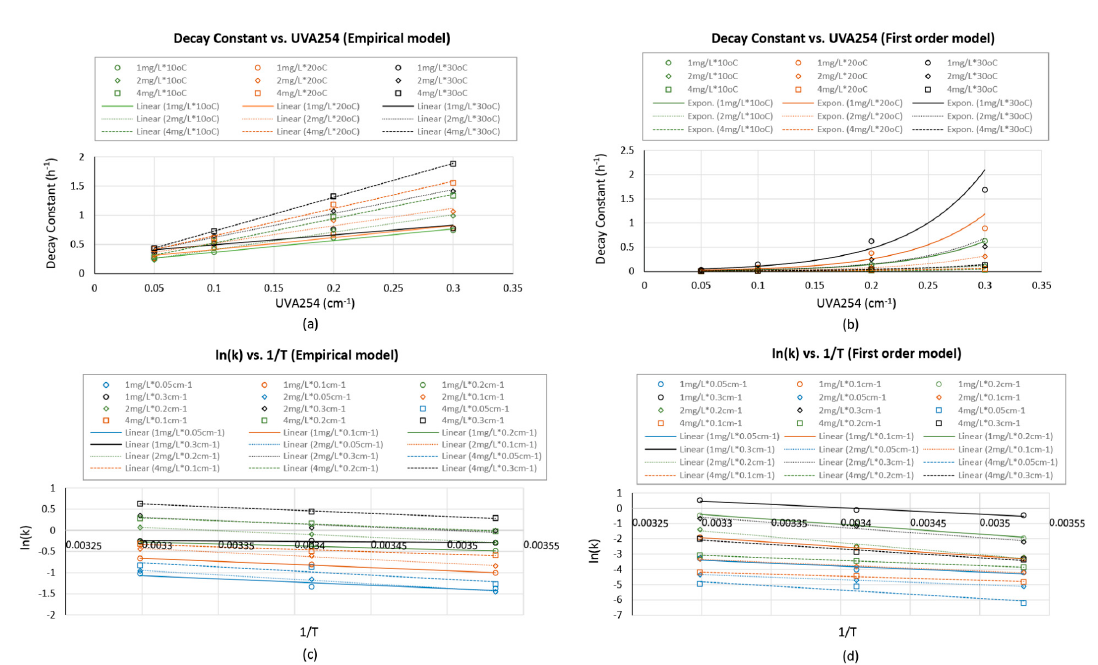
Figure 6. ( a ) Decay constants from Feben and Taras’s empirical model versus NOM of the test water. ( b ) Decay constants from first order model versus NOM of the test water. ( c ) ln ( k ) versus 1/ T for all cases– Feben and Taras’s empirical model. ( d ) ln ( k ) versus 1/ T for all cases—first order model. (Details can be found in Supplementary Material File